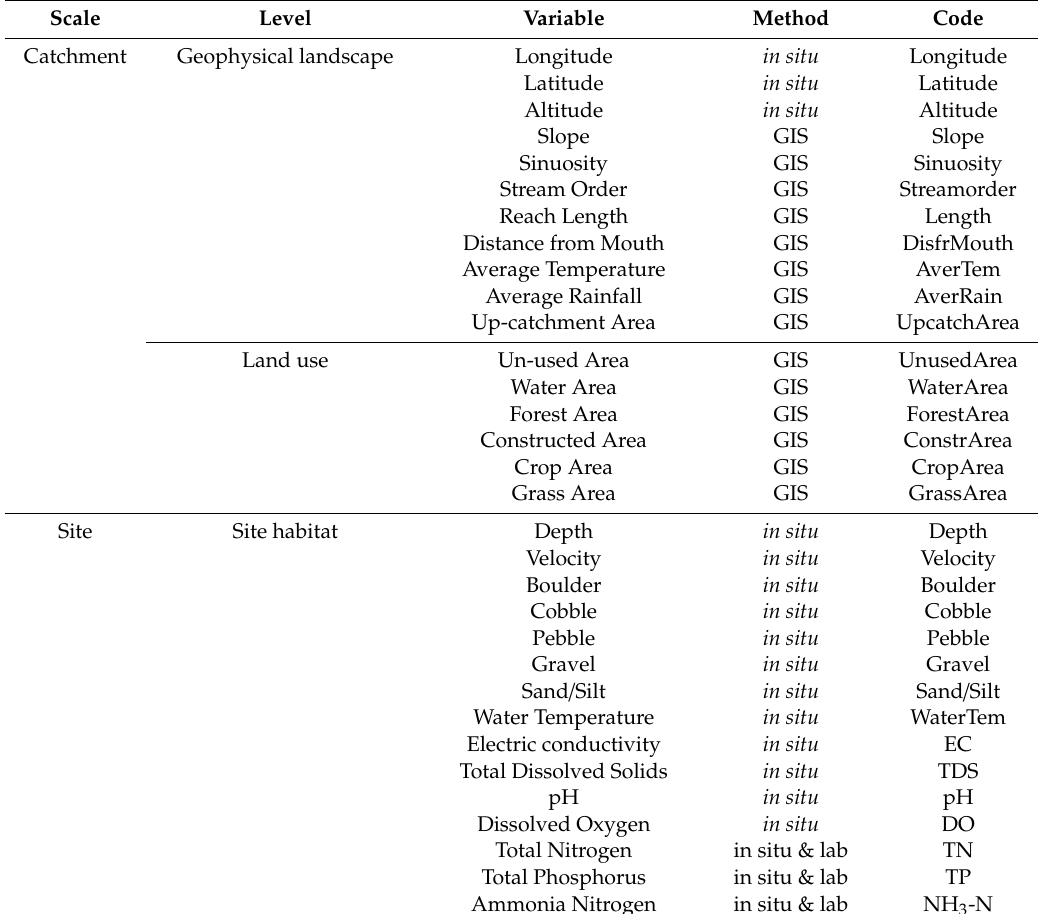
Table 1. Three levels of environmental variables used to establish the multiple linear regression (MLR) models in two